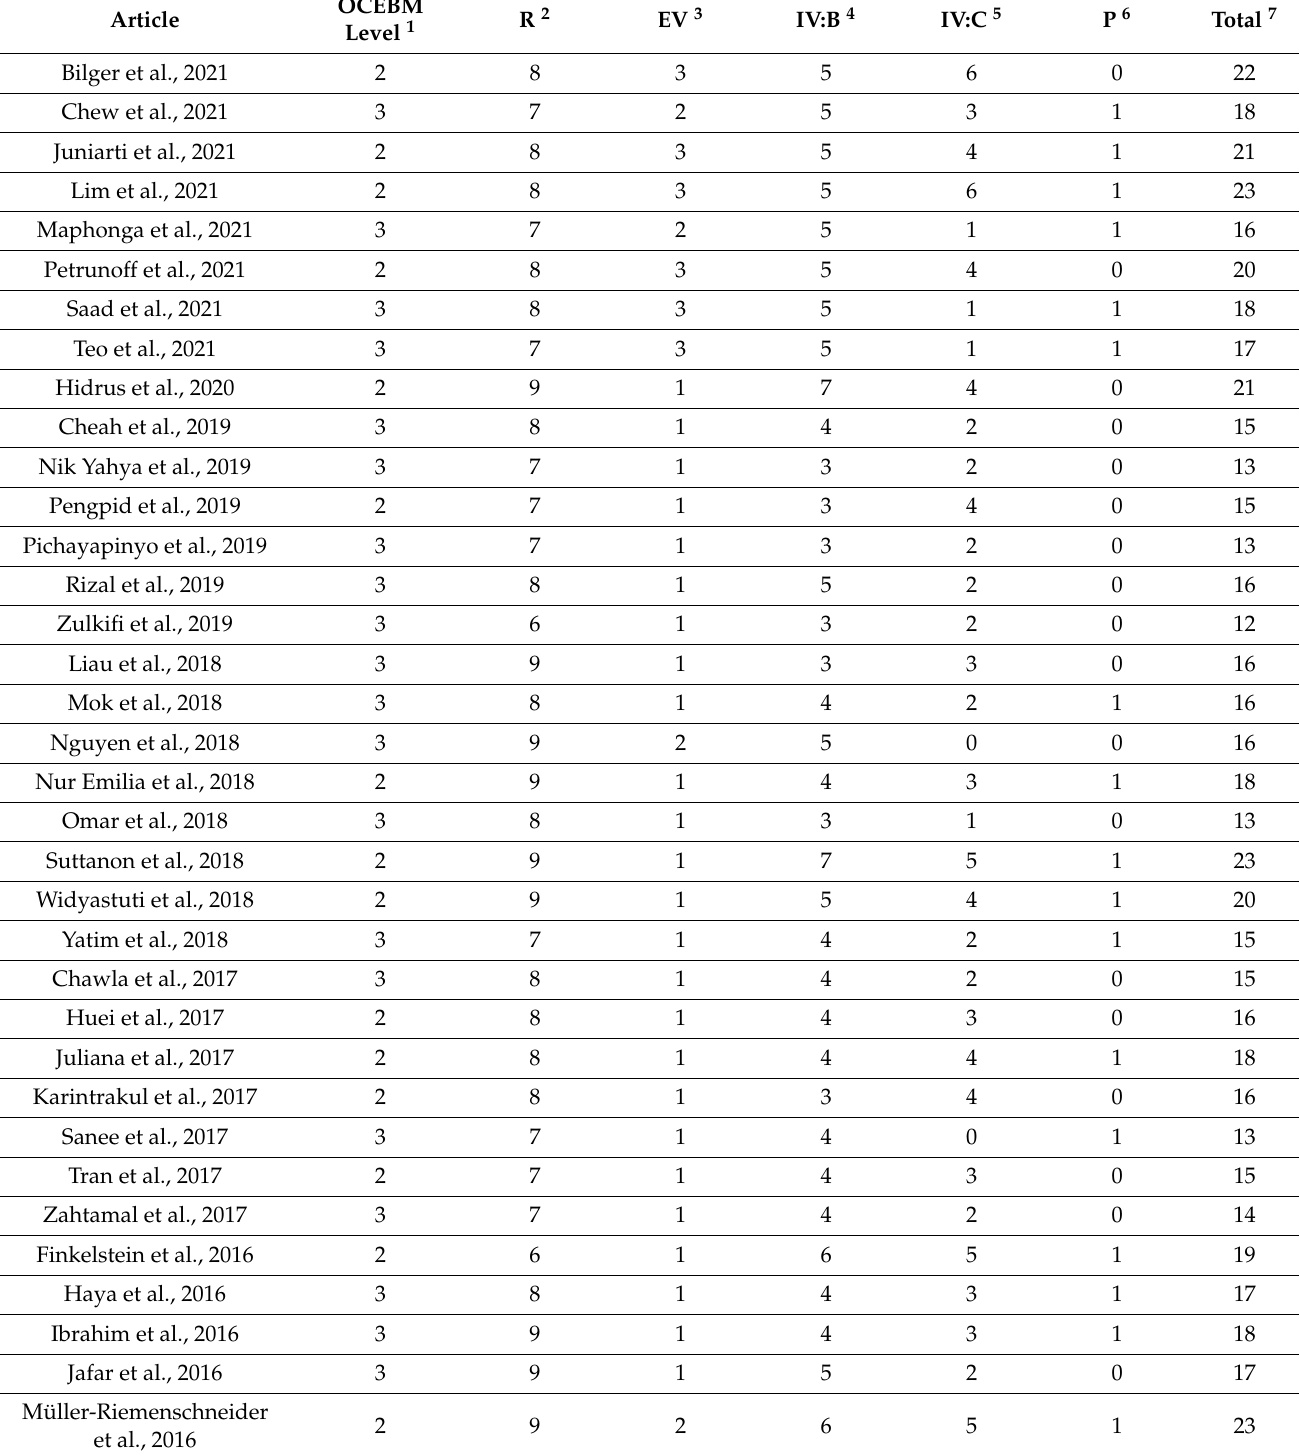
Table 1. Summary of OCEBM level, Downs and Black checklist